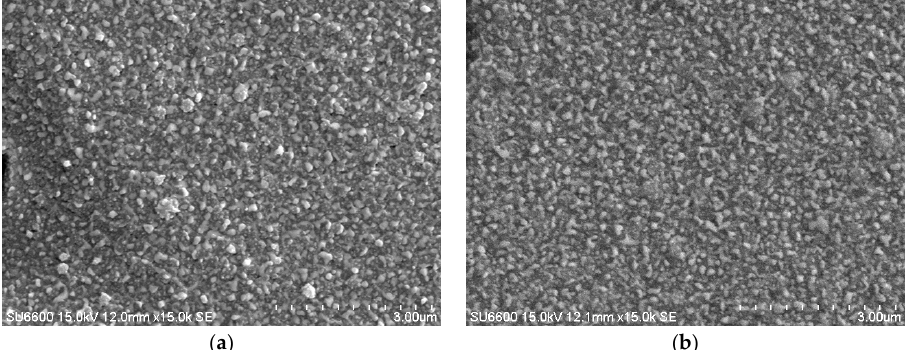
Figure 3. SEM images of Ge-Au thin films: ( a ) unannealed layers sputtered without additional bias voltage; ( b ) layers deposited with external bias voltage and annealed at 573 K.